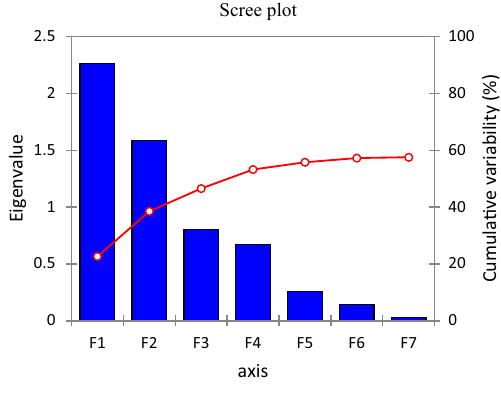
Fig. 4 Scree plot of the factor analysis after varimax rotation